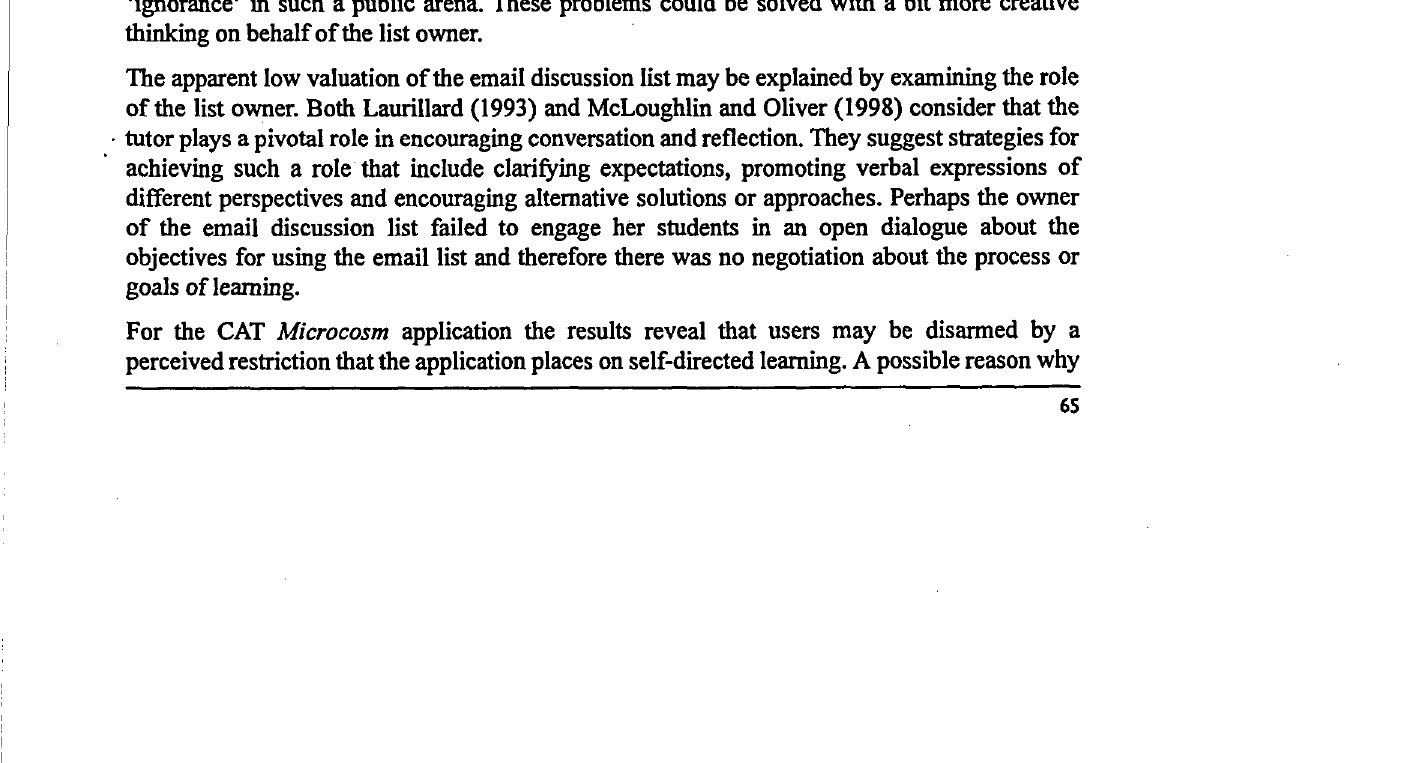
Table 3: Example comments regarding the perceived advantages and disadvantages of using the CAT Microcosm